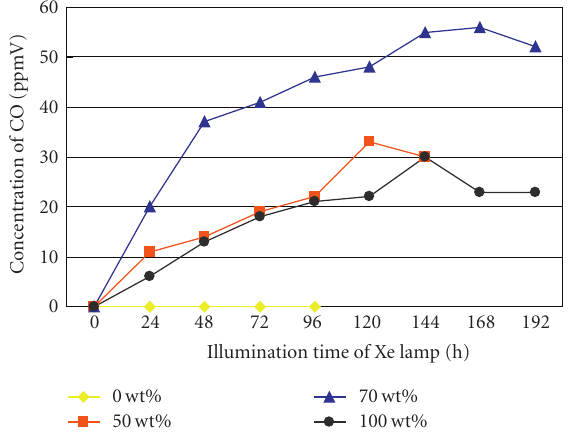
Figure 6: Comparison of produced concentration of CO among di ff erent R under the illumination condition without UV